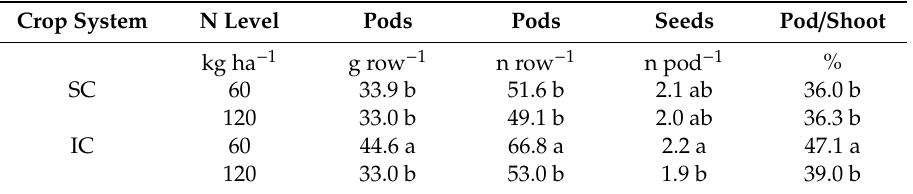
Table 2. Biomass of pods and pod yield components in field bean, as a ff ected by the Crop System × N level interaction. SC, sole crop; IC, intercrop. For each parameter, values followed by the same letter within a column are not significantly di ff erent at P < 0.05, Tukey’s test. Crop System N Level Pods Pods Seeds